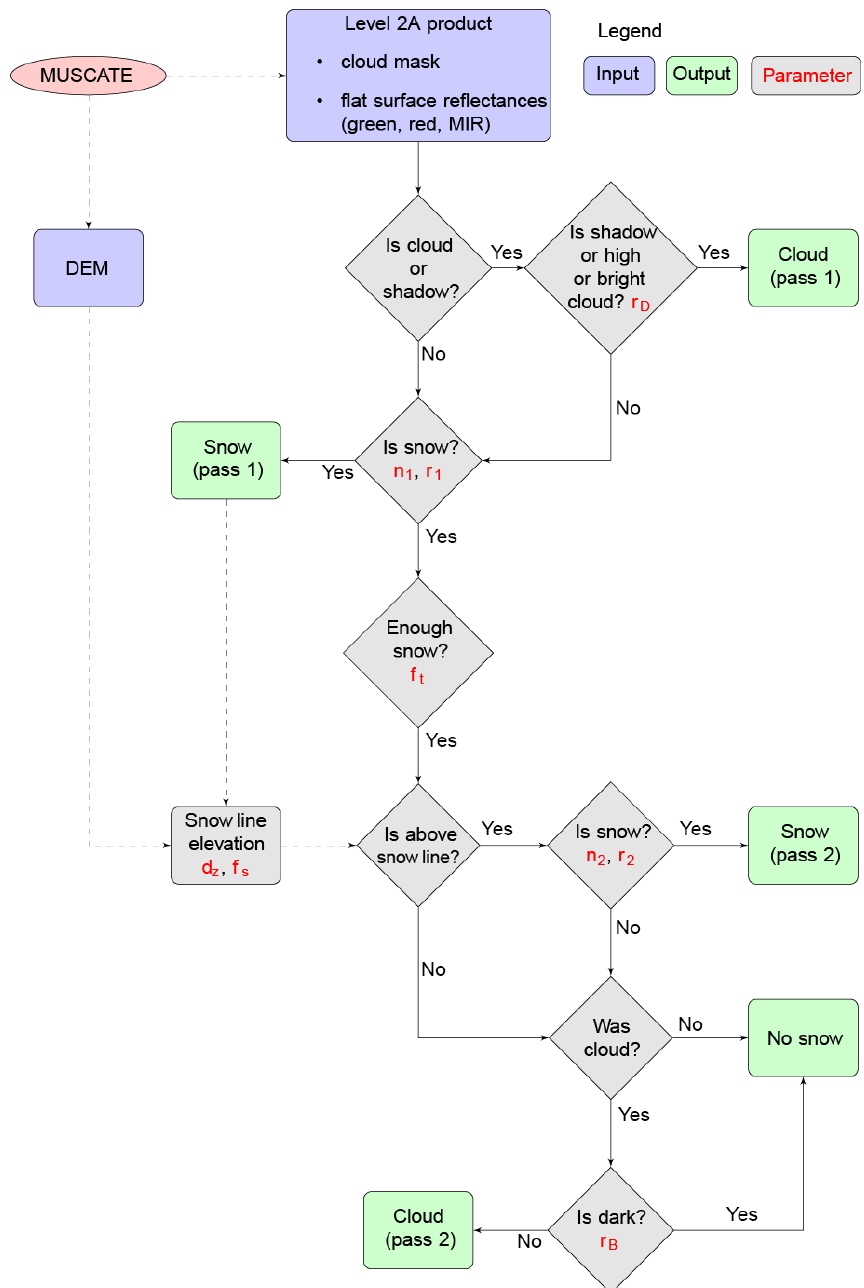
Figure 3. Flow chart of the snow detection algorithm. Table 1 gives the description and value of the algorithm parameters (written in red in this chart). MUSCATE is the scheduler which manages the L2A production for